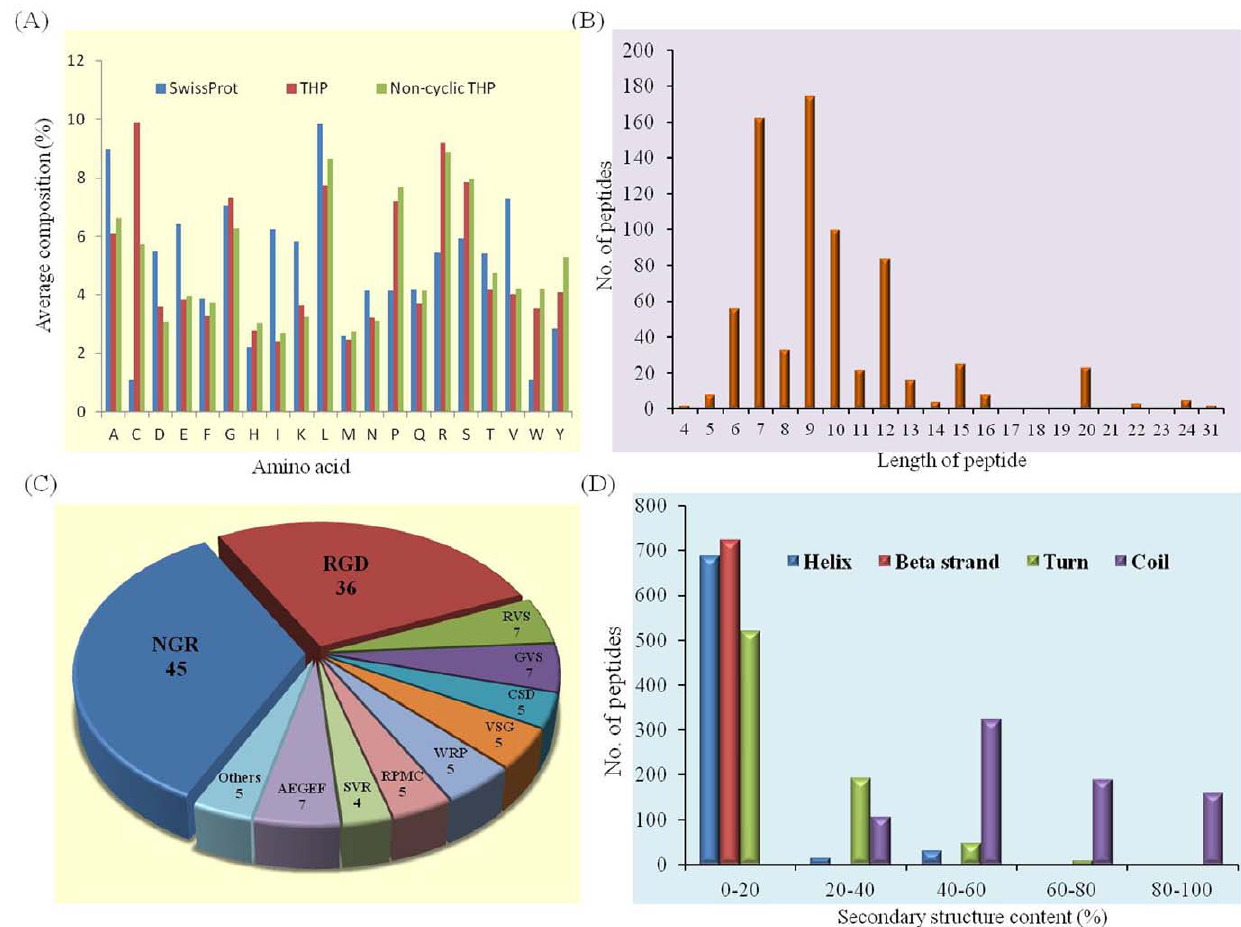
Figure 3. Distribution of tumor homing peptides in TumorHoPe. (A) Average amino acid composition of peptides (SwissProt proteins, tumor homing peptides (THP) and non-cyclic THP), (B) length wise distribution of tumor homing peptides, (C) distribution of peptides based on major sequence motifs, and (D) distribution of peptides based on secondary structure composition.